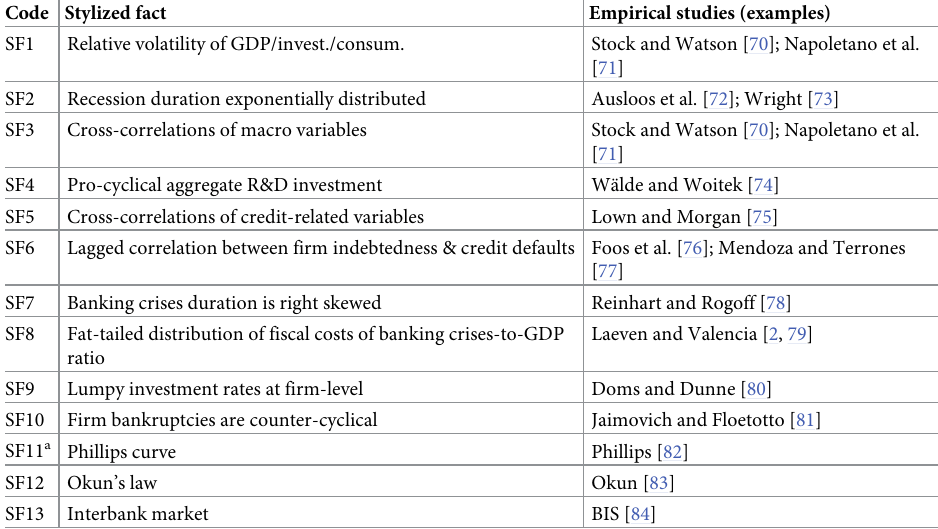
Table 1. Stylized facts replicated by the